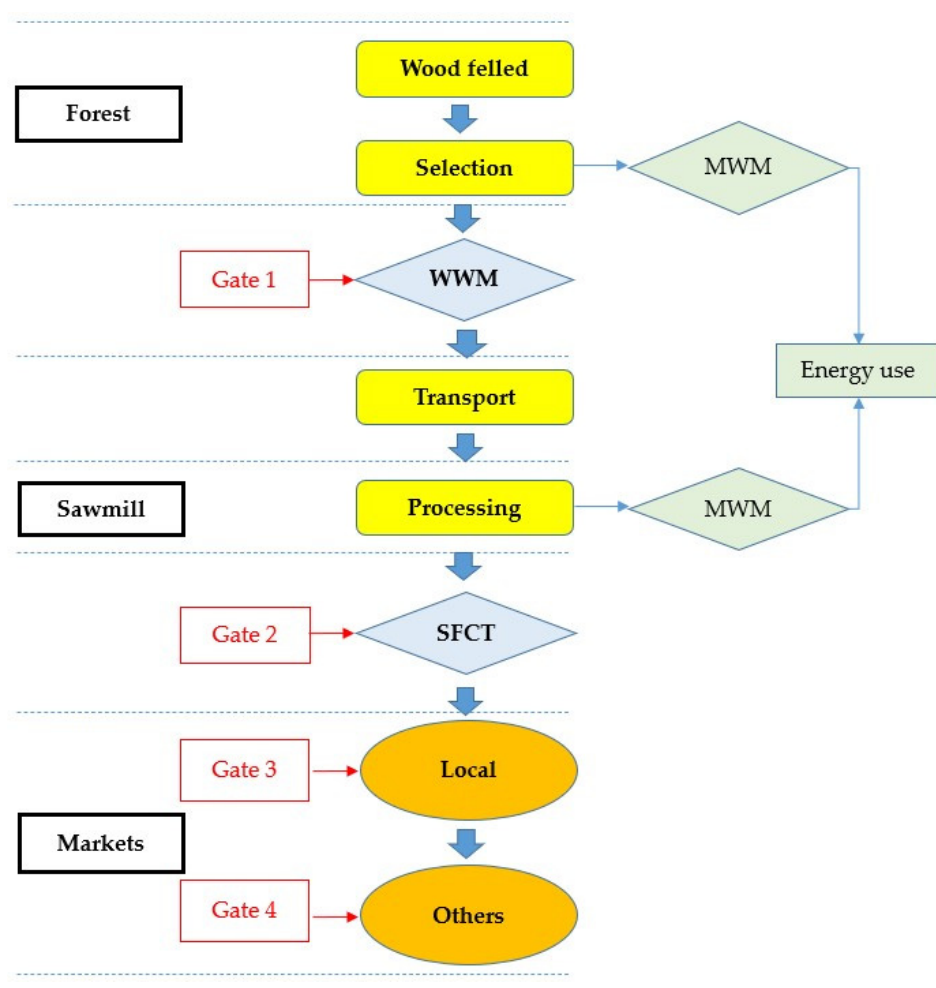
Figure 2. The supply chain of chestnut wood to the market of timber products. Legend: WWM: Workable Wood Material; MWM: Minor Wood Material; SFCT: Semi ‐ Finished Chestnut Timber.